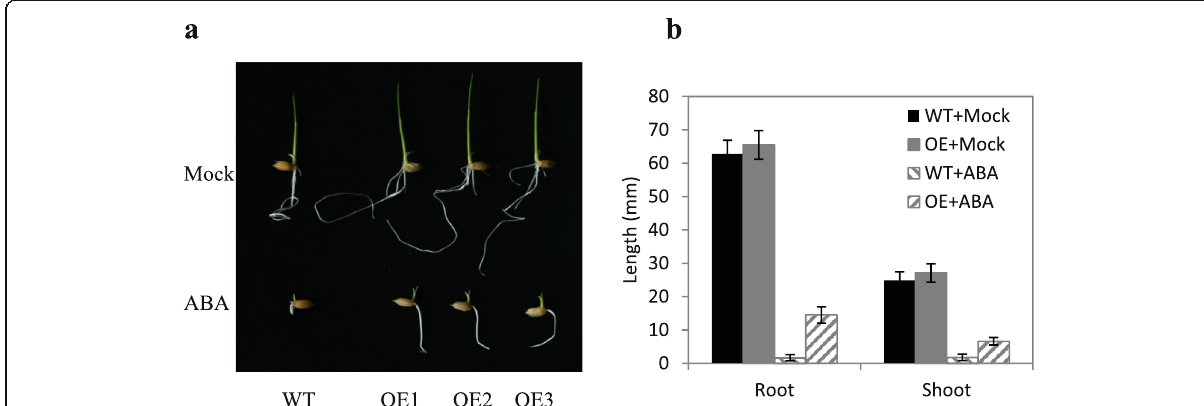
Fig. 3 Decreased ABA sensitivity in OE lines. a, Growth performance of OE lines and WT on 1%( w / v ) agar without or with 10 μ M ABA. In mock treatment, agar contained equal amount of solvent. b, Length of shoot and root of OE lines after 3 days of treatment. Shoot and root lengths were measured after 3 days of culture in the light at 30 °C.Values represent the mean ± SD of three OE lines (ten